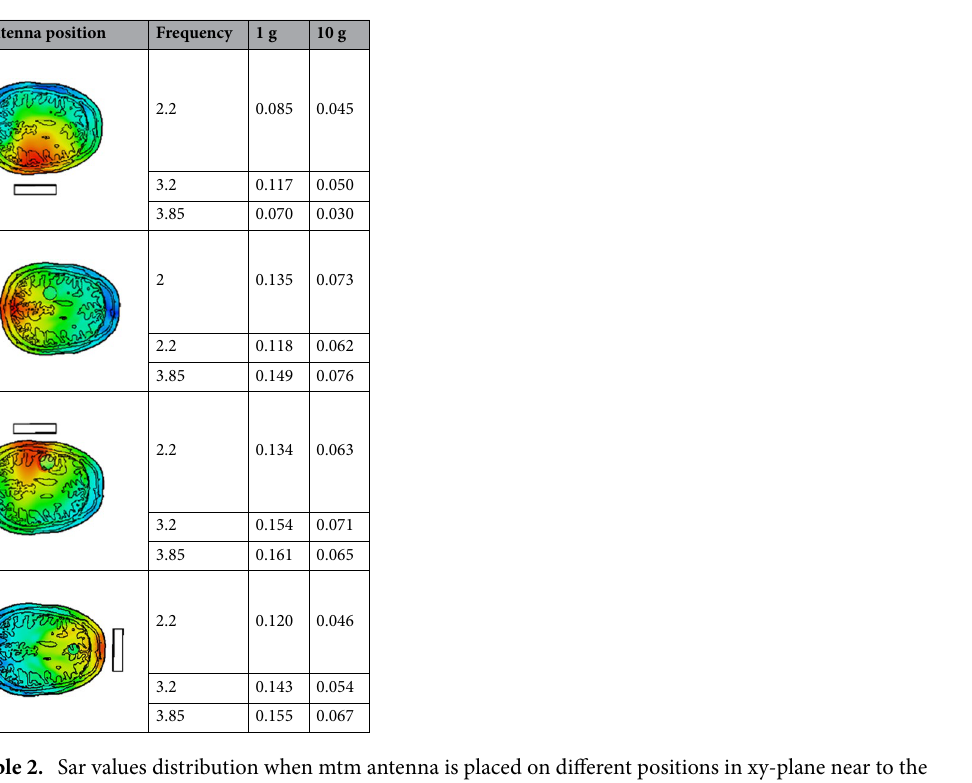
represents the SAR distribution for four different positions of the antenna for 1 g of tissue at 2.2 GHz. The analy- sis further continues to calculate the SAR distribution for 1 g and 10 g of tissue in four different positions with different resonance frequencies as per the scattering parameters, which is shown in Table 2. Notably, 10 g tissue absorbs less electromagnetic energy compared to the 1 g of tissue. The maximum SAR positions are identified at the exterior head tissue layer. The maximum SAR positions are identified at the exterior head tissue layer. The maximum values are 0.117, 0.149, 0.161, and 0.155 of 1 g tissue, and 0.050, 0.076, 0.071, and 0.067 of 10 g tissue, respectively, for the four different antenna positions which satisfy the IEEE public radiation exposure limit of 1.6 W/kg 63 .